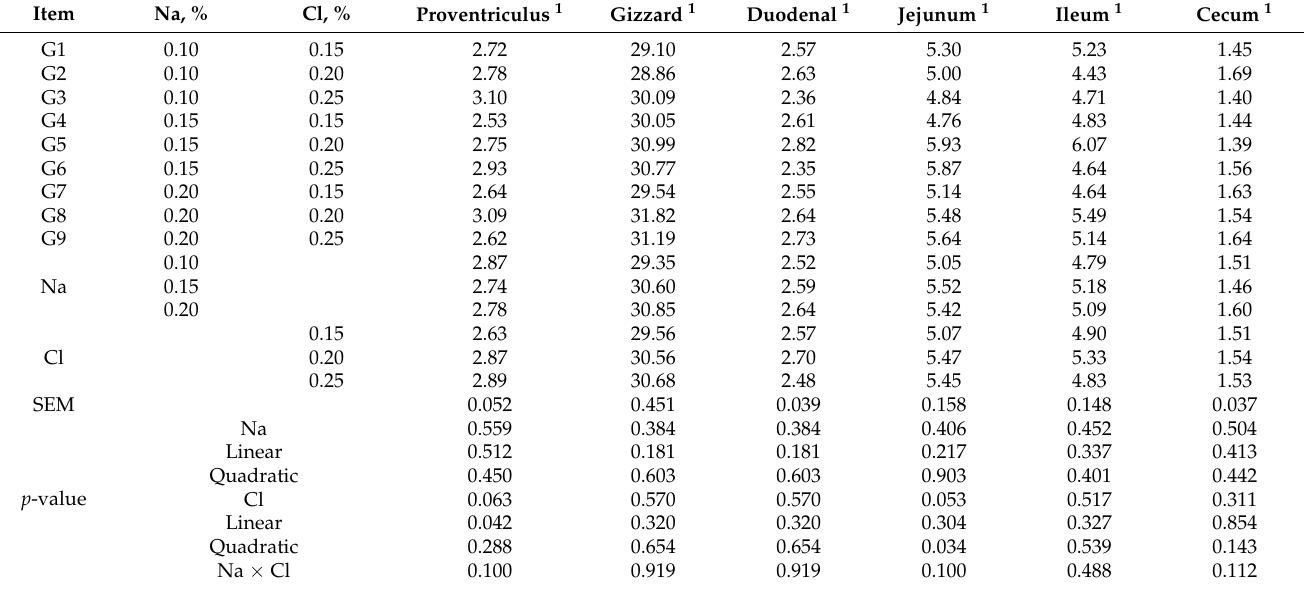
Table 3. Effects of dietary Na and Cl on digestive tract index of 70-day-old geese ( n =